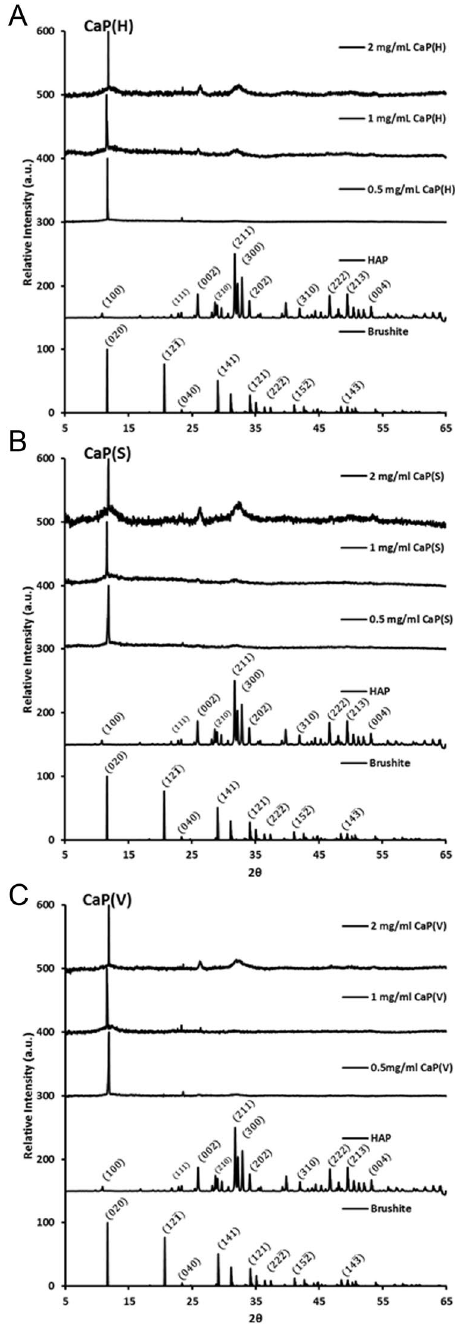
Figure 3. ( A – C ) XRD patterns of the precipitates formed from the reaction of 20 mM calcium chloride and 12 mM sodium phosphate dibasic in the presence of CaP(S) STLPIPHEFSRE, CaP(V) VTKHLNQISQSY and CaP(H) SVSVGMKPSPRP at initial concentrations: 0.5, 1 and 2